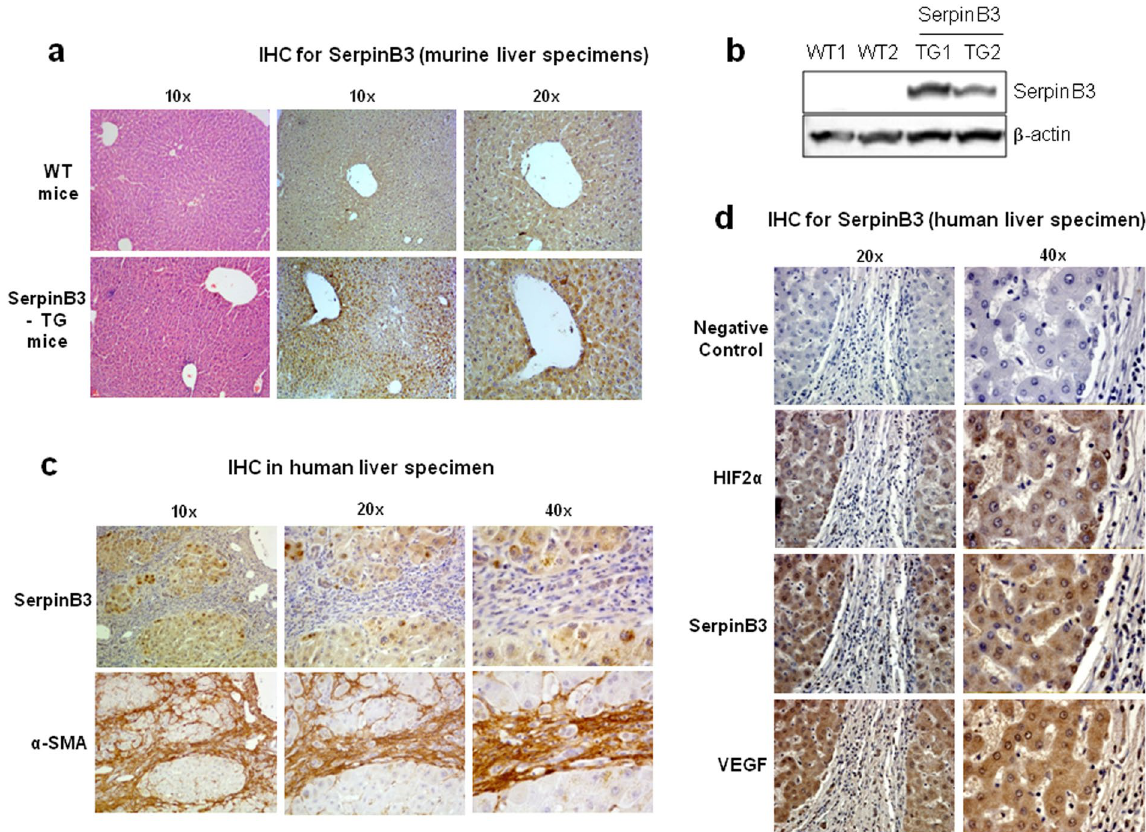
Figure 4. SerpinB3 overexpression in TG mice and human liver specimens from HCV patients. ( a ) Liver morphology (hematoxylin/eosin staining) and immunohistochemistry (IHC) for SerpinB3 expression in the liver of control WT and TG mice. Original magnification as indicated. (b) Western blot analysis of SerpinB3 protein levels performed on total liver extracts obtained from either WT and TG mice. Equal loading was monitored by re-blotting membranes for β -actin. The cropped gels shows in this Fig. have been run under the same experimental conditions. Immunohistochemistry analysis for (c) SerpinB3 and α -smooth muscle actin ( α -SMA) or (d) for HIF2 α , SerpinB3, and VEGF-A in liver specimens from HCV infected patients (METAVIR